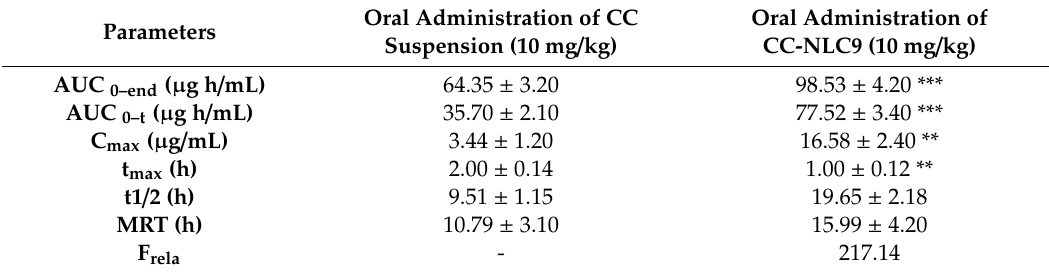
Figure 8. Average plasma concentration vs. time profile following single oral administration of CC-NLC and CC suspension. Table 4. Pharmacokinetic parameters of CC in rats following oral administration of CC suspension and CC-NLC at a dose of 10 mg /